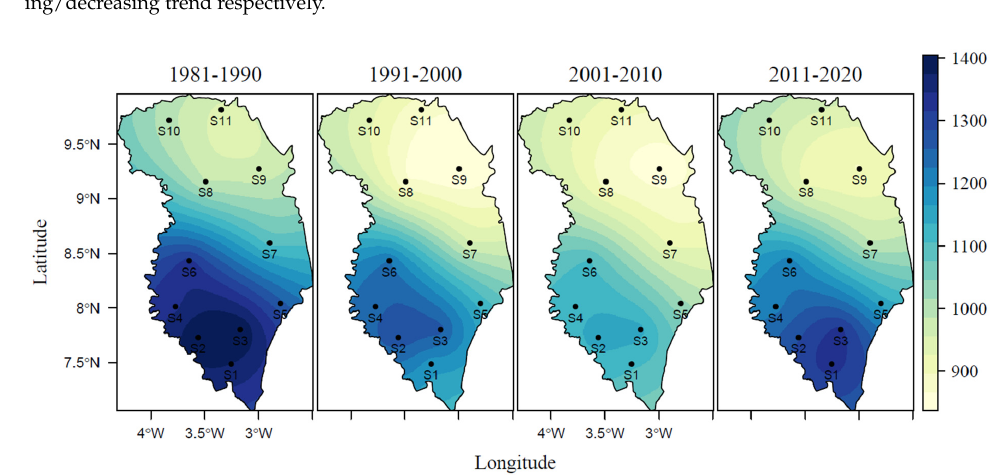
Figure 2. Spatial distribution of annual total precipitations (PRCPTOT) (mm) per decade in the Zanzan region. Stations (S1 = Koun Fao, S2 = Kouassi-datékro, S3 = Tanda, S4 = Sandegué, S5 = Bondoukou, S6 = Nassian, S7 = Sapli, S8 = PN Comoé S1, S9 = Bouna, S10 = Téhini, S11 = Doropo).